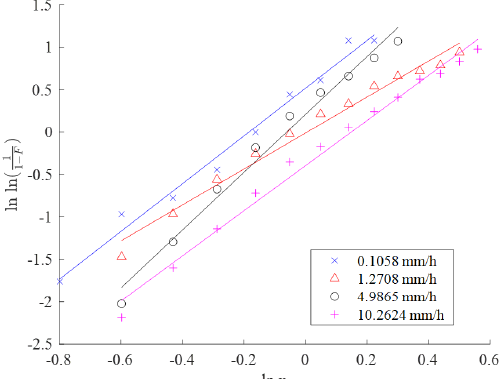
Figure 7. Evaluation of Eq. (5) to derive the constants A and p .